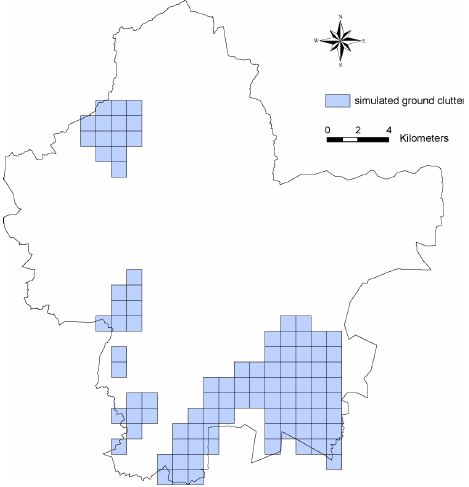
Fig. 2. Simulated ground clutters over the Greater Lyon, for the Hydram rain accumulation period (2001–2006)